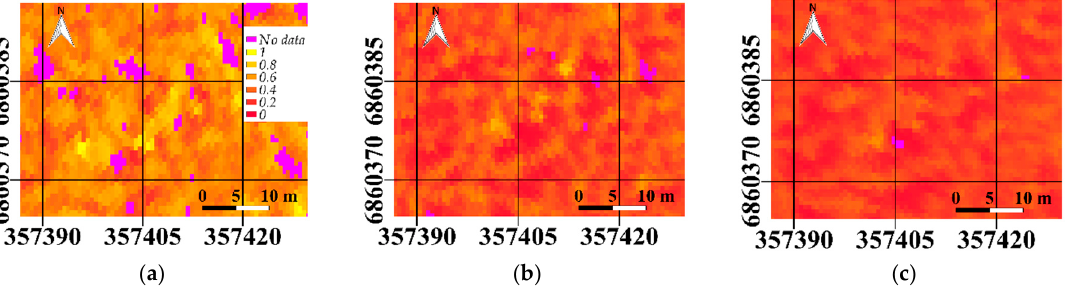
Figure 6. Spatial variation of the canopy sunlit fraction for β = 19 ◦ ( a ), β = 55 ◦ ( b ), β = 76 ◦ ( c ). Purple pixels were masked out (NDVI < 0.8). The color scale is the same for all three rasters. The scatter angle closest to the hot spot ( β = 19 ◦ ) produced higher average TOC HDRF values than scatter angles 55 ◦ and 76 ◦ in the visible region (400–700 nm), but less reflectance in the near-infrared region (700–870 nm) (Figure 7) for any fixed interval of the sunlit fraction α S . To investigate this, we divided the average TOC HDRF reflectance at the oblique angles ( β = 19 ◦ and 76 ◦ ) by the reflectance close to nadir ( β = 55 ◦ ). We observed a general decrease in the HDRF (19 ◦ )/HDRF (55 ◦ ) ratio with α S , with especially strong dependence in the visible wavelengths. The ratio HDRF (76 ◦ )/HDRF (55 ◦ ) remained more constant and was close to unity across the whole measured spectrum (Figure 8). In both cases (HDRF (19 ◦ )/HDRF (55 ◦ ) and HDRF (76 ◦ )/HDRF (55 ◦ )), the highest HDRF ratio values were obtained for α S between 0.43 and 0.45.